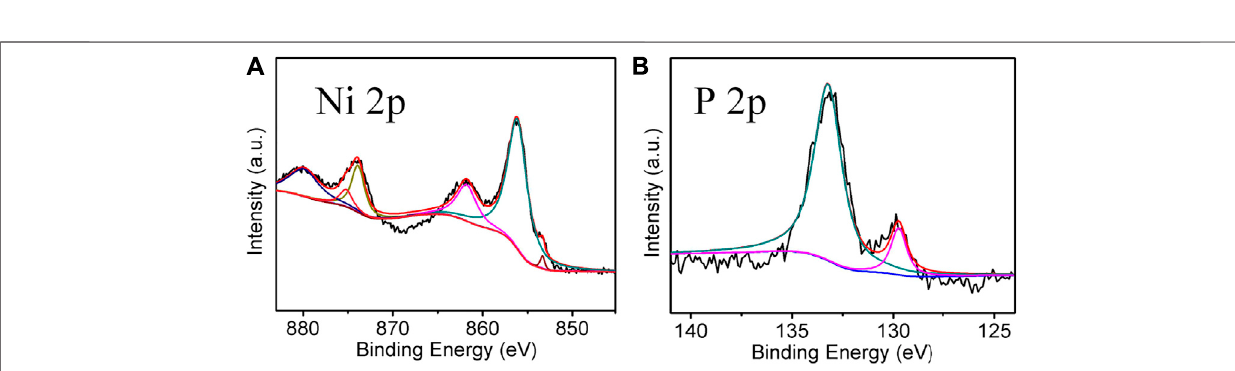
FIGURE 3 | XPS spectra (A) Ni 2p, (B) P 2p regions for Ni 2 P